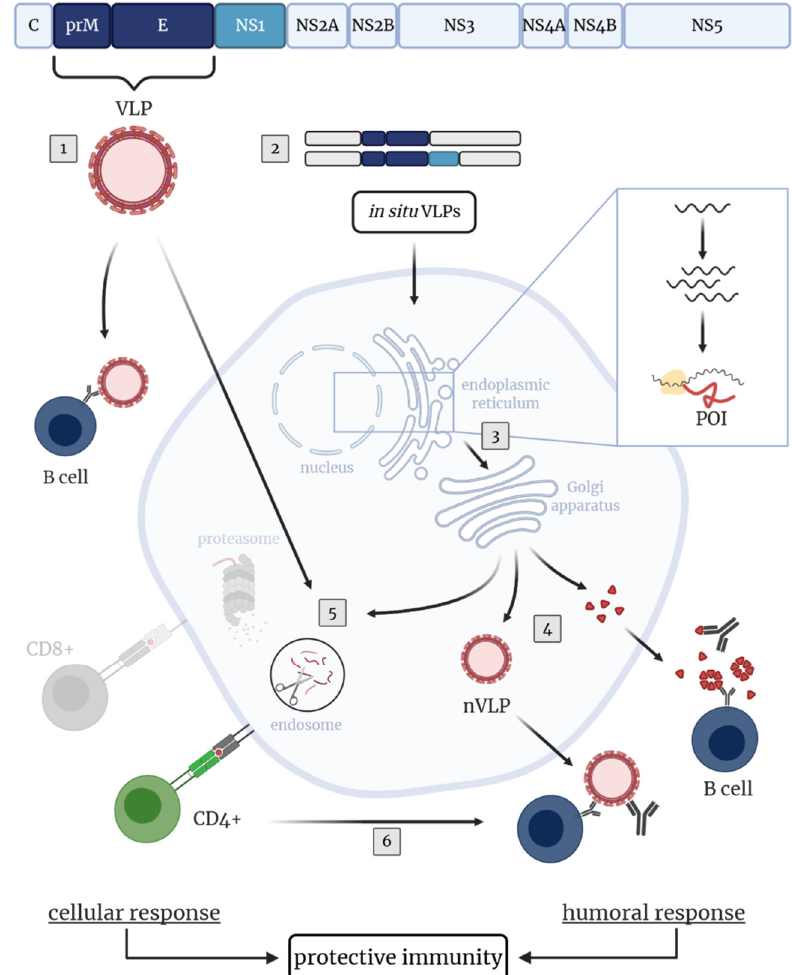
Figure 2. TBEV-specific immunity upon immunization with virus-like particles (VLPs). The TBEV polyprotein with proteins inducing protective antibody responses (prM, E, NS1) is shown. Upon immunization with purified VLPs (1) or vector-based vaccines co-expressing prM and E (in situ production of VLPs, (2)), mainly humoral immune responses are induced. Inclusion of the NS1 protein in these vector-based vaccine approaches may improve the protective immunity. (3) Vector-based immunization leads to the synthesis of proteins of interest (POIs), which are processed on di ff erent pathways leading to humoral and / or cellular immune responses. (4) Humoral immune response: POIs are either secreted into the extracellular space (NS1) or assemble into novel VLPs (nVLPs; prM-E) which are subsequently released from the cell. The secreted proteins and de novo produced (nVLPs) or directly administered VLPs, respectively, induce the production of TBEV-specific B cells and antibodies. (5) Cellular immune response: The POIs or endocytosed VLPs, respectively, are degraded into peptides mainly by host proteases in endosomes leading to antigen presentation via MHC class II molecules to CD4 + T cells. (6) CD4 + T cells promote the activation and proliferation of TBEV-specific B cells driving e ffi cient antibody responses with development of memory responses. Created with BioRender.com.